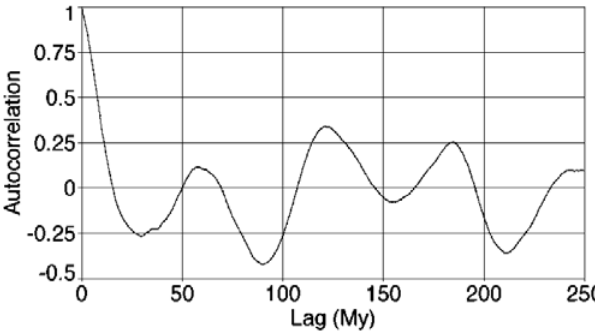
a peak at approximately 140 Myr is also visible.